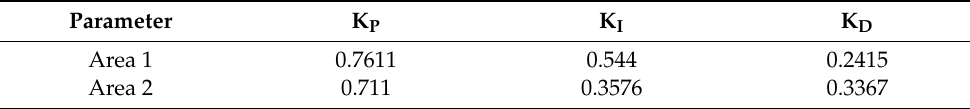
Table 2. PID parameter values for 1% SLP.